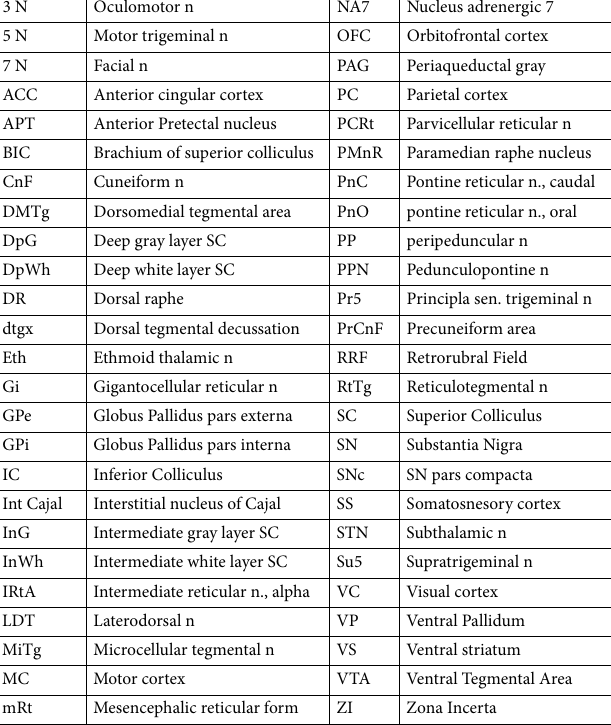
Table 1. List of